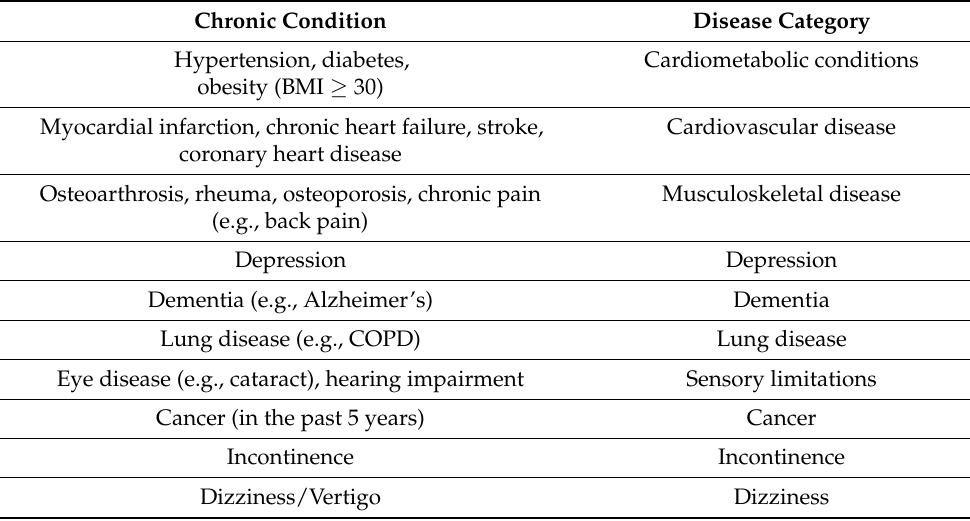
Table 1. Individual chronic conditions and disease